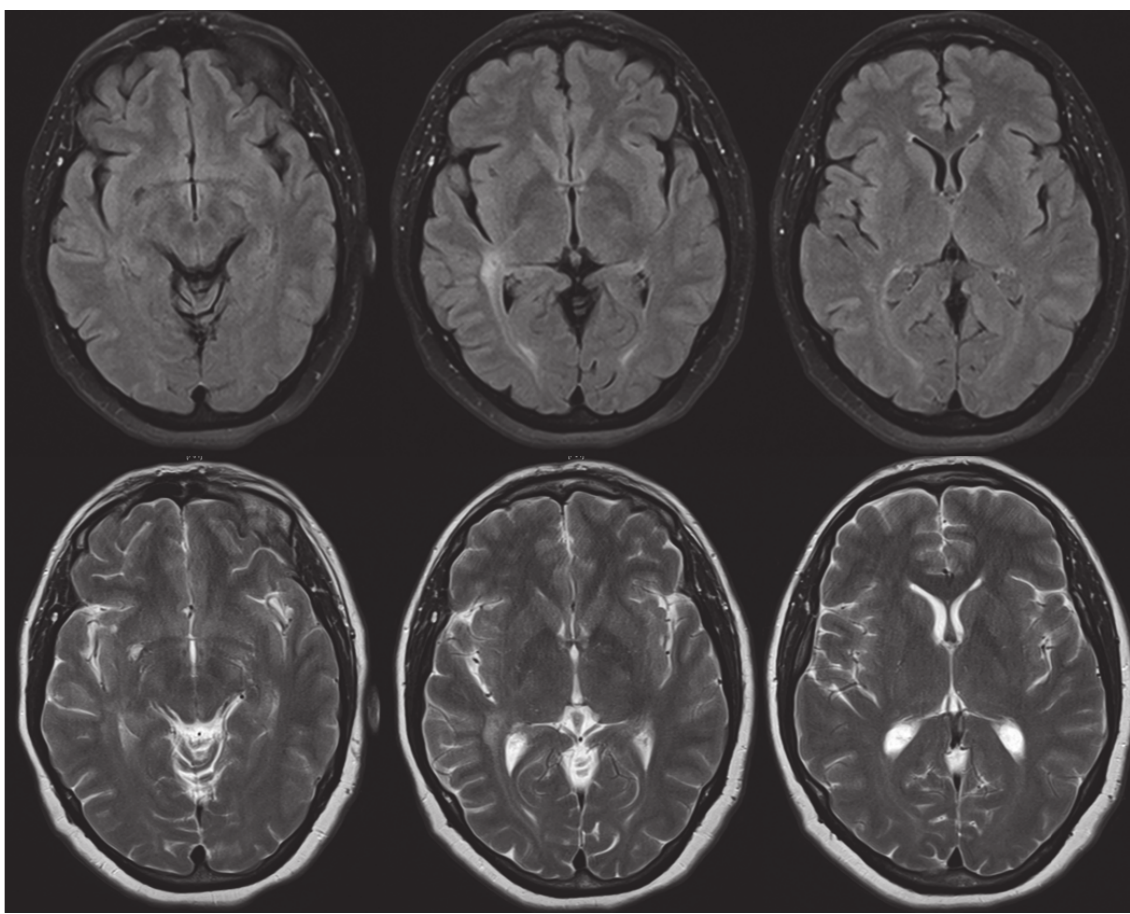
Figure 3: MRI of the brain showing almost complete resolution of the previously noted